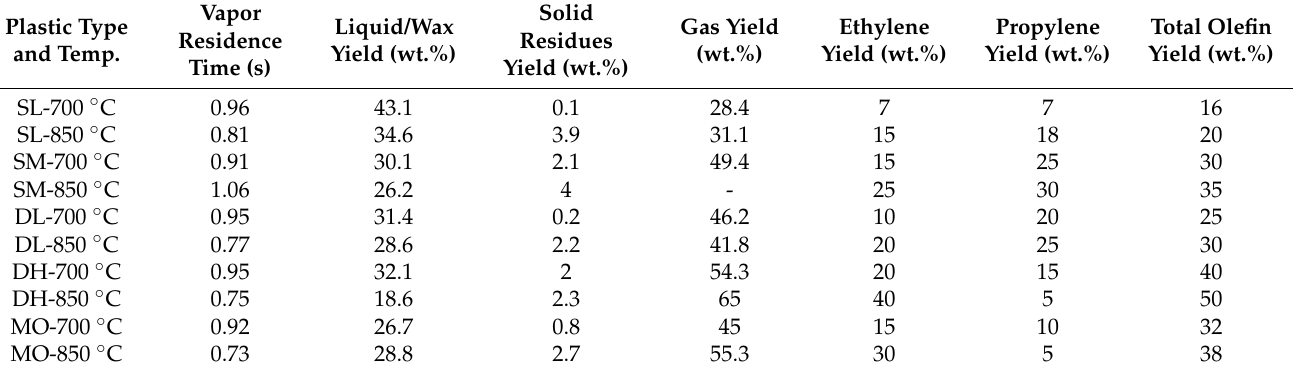
Table 6. Pyrolysis of different plastic wastes [36].